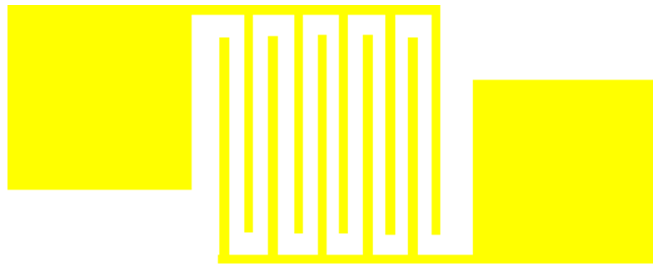
Figure 1. The style of IDE. Table 1. The electrode parameters of IDE. Table 1. The electrode parameters of